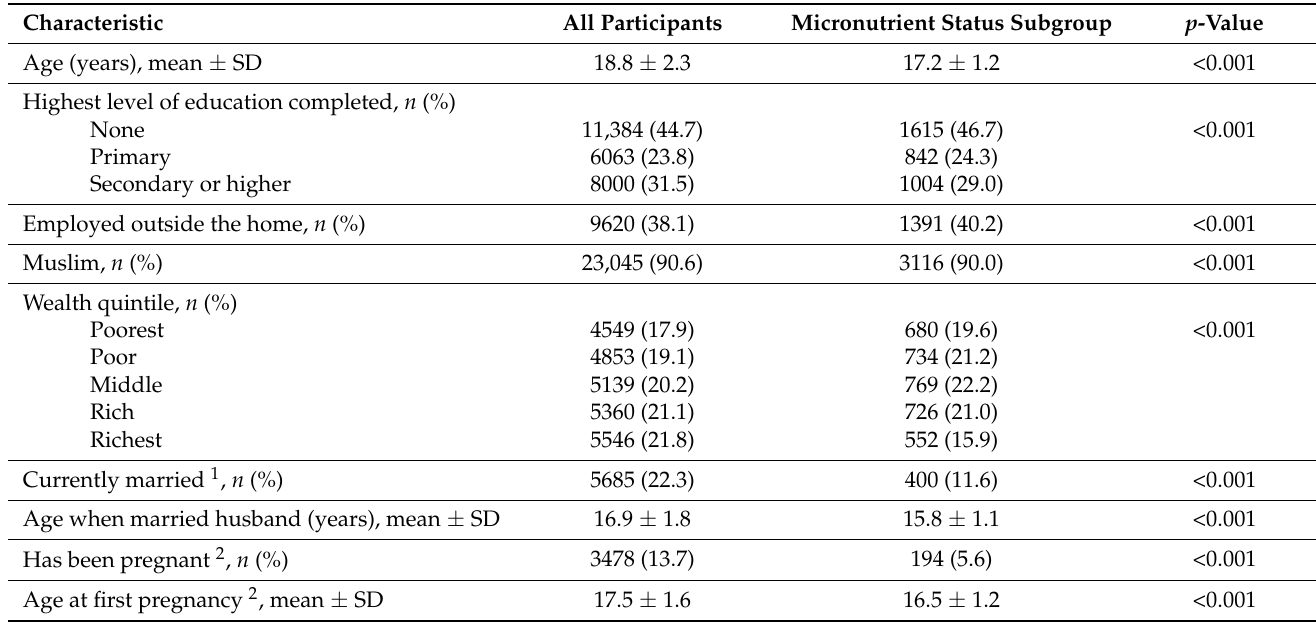
Table 1. Descriptive characteristics among all participants at enrolment in the Matiari emPowerment and Preconception Supplementation (MaPPS) Trial ( n = 25,447) and the micronutrient status subgroup ( n =